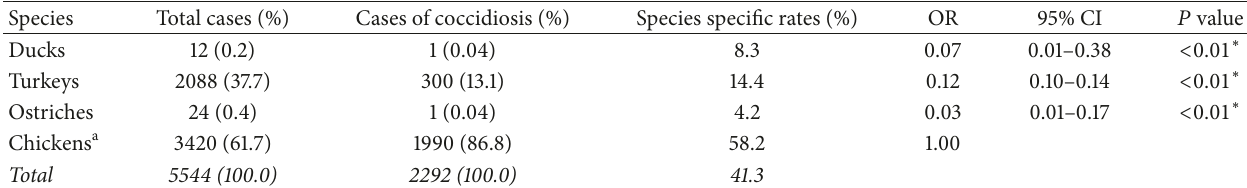
Table 4: Species distribution of avian coccidiosis in Osun State, Nigeria (2006–2015).